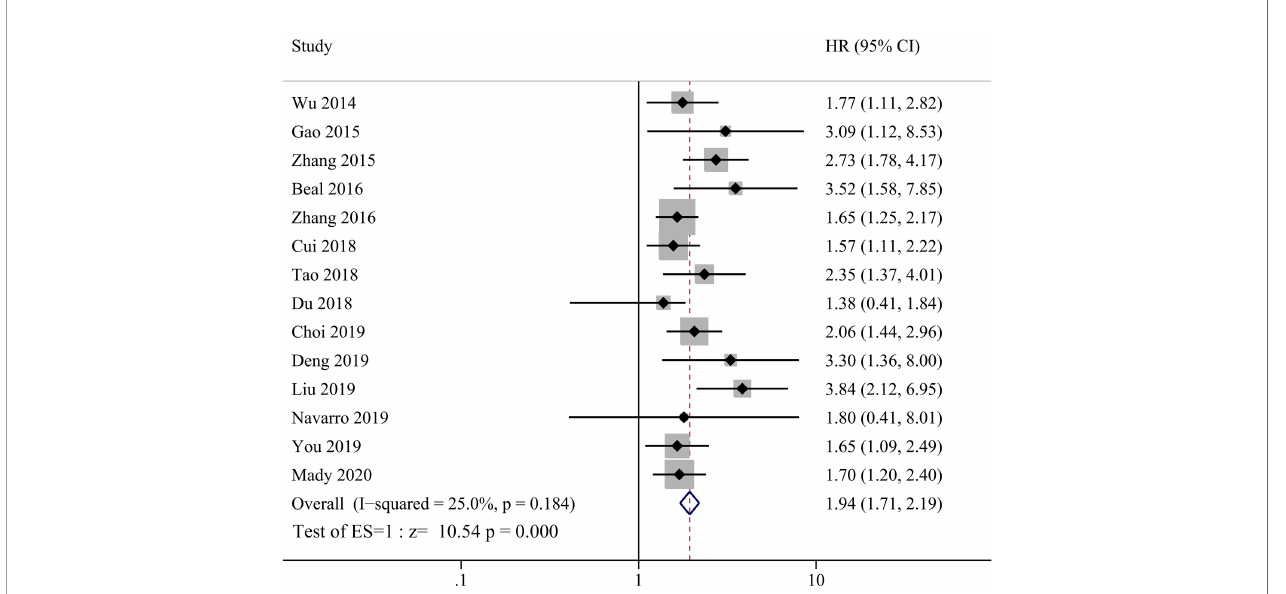
FIGURE 2 | Forest plot for the association between neutrophil-lymphocyte ratio (NLR) and overall survival of patients with Gallbladder carcinoma (GBC).